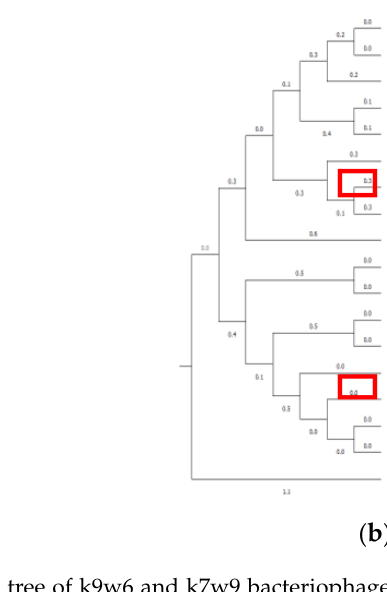
Figure 10. The phylogenetic tree of k9w6 and k7w9 bacteriophage ( a ) DNA polymerase, ( b ) Tail fiber protein. The tree was constructed by using the neighbour joining method with 2000 bootstrap replications. Pectobacterium and Lactococcus bacteriophage was used as an out-group. The GenBank accession numbers are also provided after bacteriophage names, in parentheses. This tree shows the relationship of k9w6 and k7w9 DNA polymerase and Tail fiber protein with other close and distant